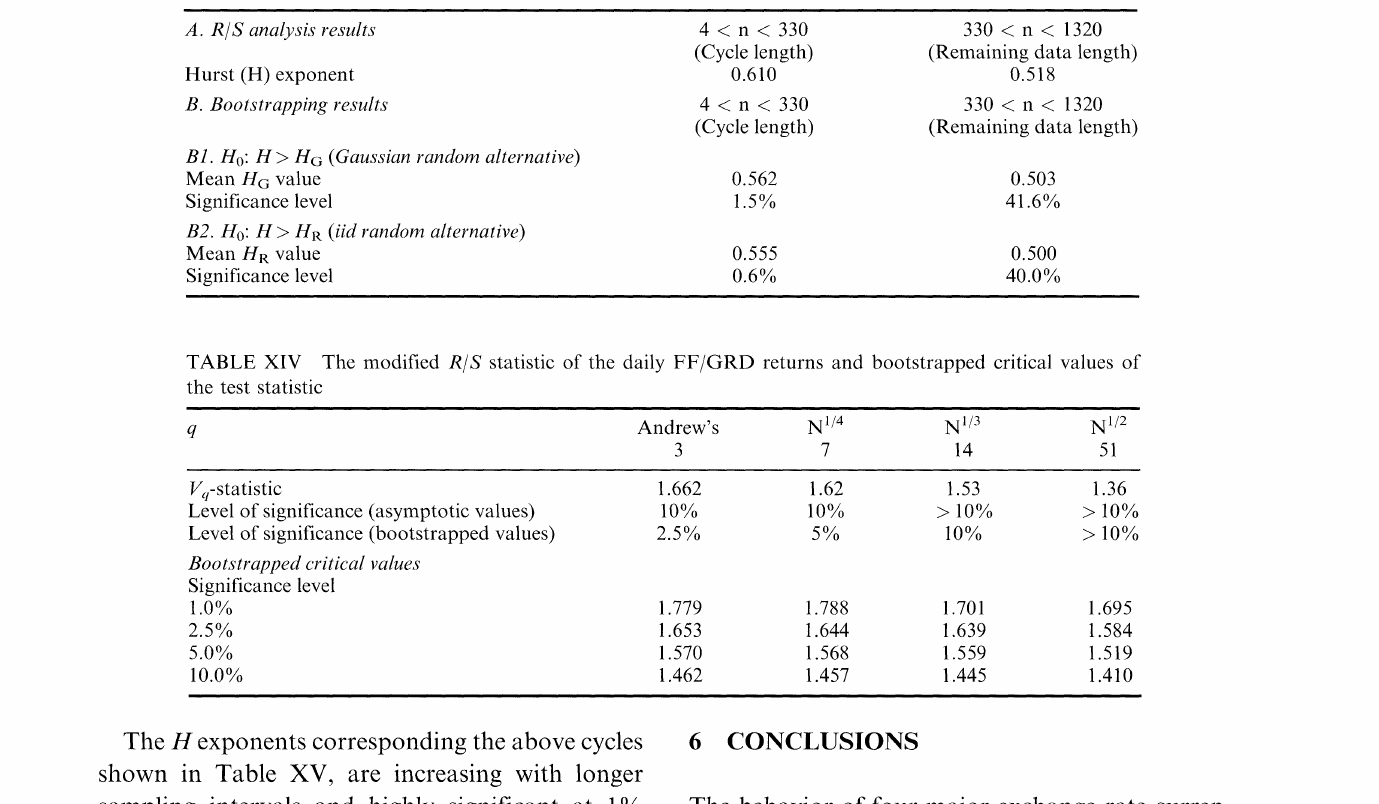
FIGURE 10 R/S analysis of the FF/GRD daily returns (a) Hurst exponent estimation through the R/S statistic plot (b) Cycle- length estimation through the V-statistic plot. TABLE XIII Hurst estimates and test of significance against two random alternatives of the daily FF/GRD returns